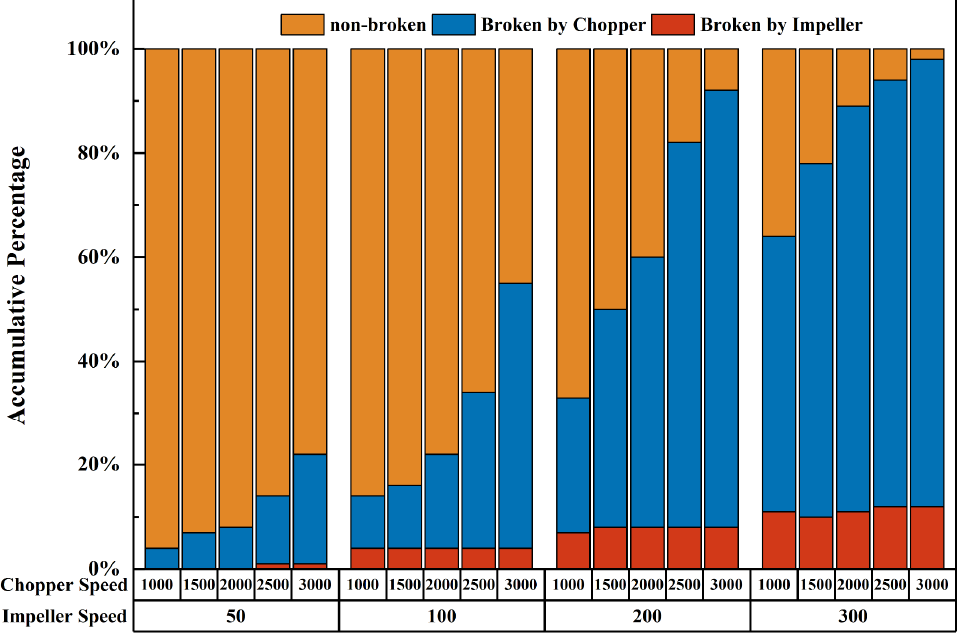
Figure 11. Accumulation of breakage forms.